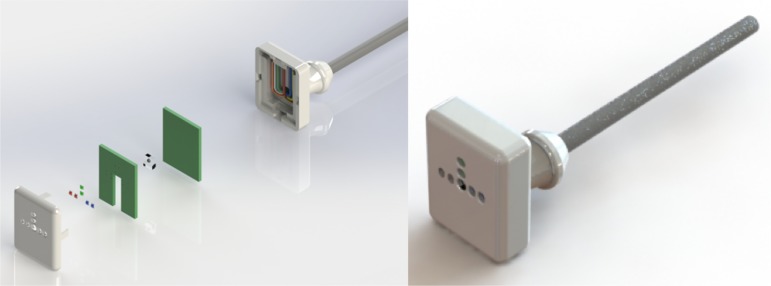
Prototype of the sensor probe.(A) Exploded perspective drawing of optoelectronic components fitting in the cover probe. (B) 3D illustration of the second version of the sensor module. Note: Exact positions between the LEDs and photodiode, in the middle of the sensor are: Red 1 = 3.3 mm; Red 2 = 6.5 mm; Green 1 = 4.0 mm; Green 2 = 7.2 mm; Blue 1 = 3.3 mm; Blue 2 = 6.5 mm.